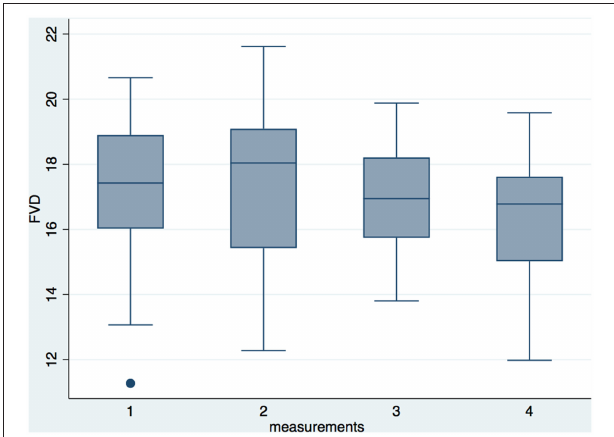
+ Statistically significant results (except for intercept term) are displayed in bold. ** Fitted multivariable adjusted model: estimated microcirculatory parameters = ß 0 + ß 1 * days of life + ß 2 * gestational age at birth + ß 3 * mean arterial blood pressure + ß 4 * heart